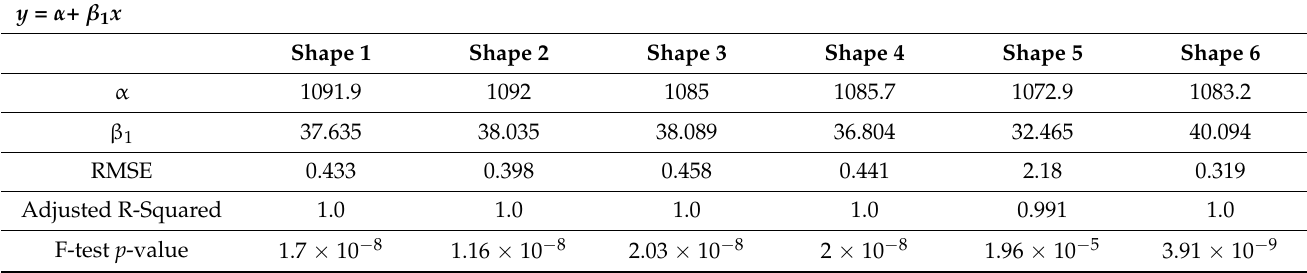
Table 14. Fitted lines of infiltration rate.